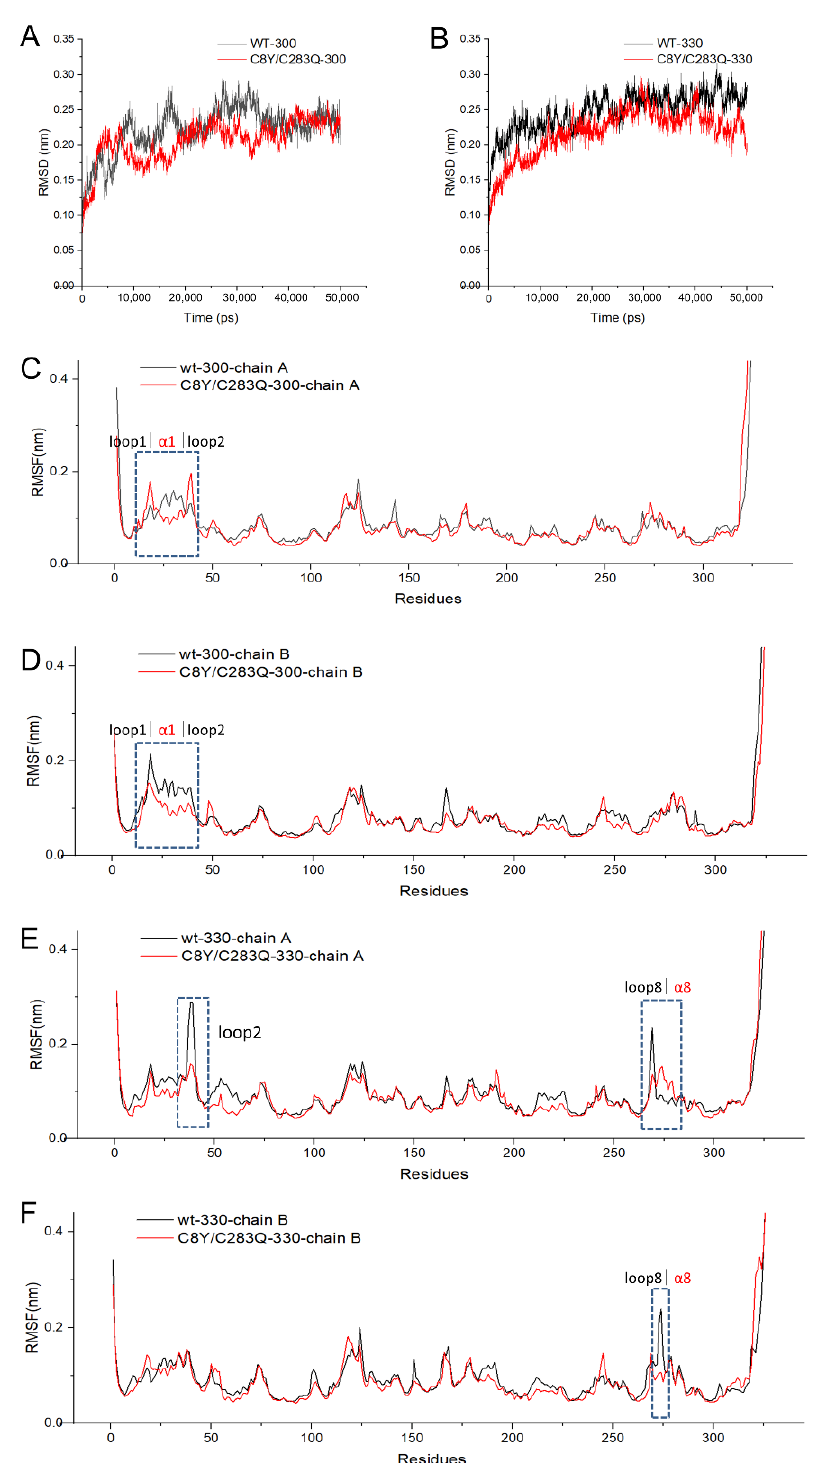
Figure 4. RMSD and RMSF values of AsA and mutant C8Y/C283Q over time during MD simulation. ( A ) RMSD values of AsA and mutant C8Y/C283Q simulated at 300 K. ( B ) RMSD values of AsA and mutant C8Y/C283Q simulated at 330 K. ( C ) RMSF values of chain A in AsA and mutant C8Y/C283Q simulated at 300 K. ( D ) RMSF values of chain B in AsA and mutant C8Y/C283Q simulated at 300 K. ( E ) RMSF values of chain A in AsA and mutant C8Y/C283Q simulated at 300 K. ( F ) RMSF values of chain B in AsA and mutant C8Y/C283Q simulated at 300 K. The parts marked by the dotted line were the areas with large difference between wild-type and mutant.